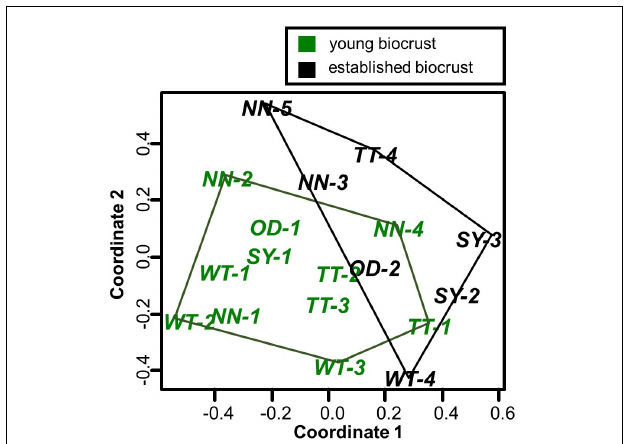
FIGURE 8 | nMDS plot showing the present morphotaxa composition of green algae and cyanobacteria isolated from young and established biocrusts sampled in potash tailings pile environments (OD, Oedesse; SY, Shreyahn; TT, Teutschenthal; WT, Wietze; NN, not further described) polygons show the biocrust types; stress = 0.179 and Nostoc sp. were prominent cyanobacteria